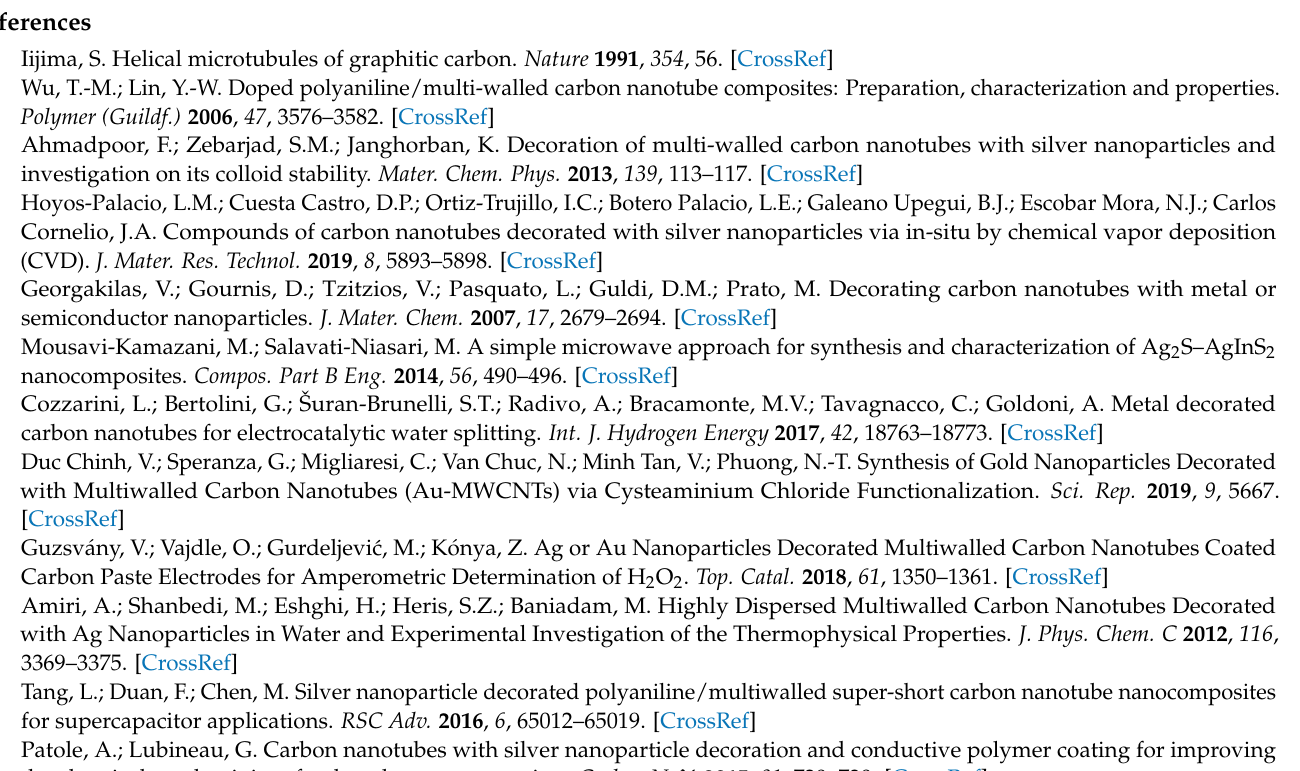
Table S31: two-way ANOVA between the groups of MWCNTs and AgMWCNTs samples dispersed in water with different temperatures (20–60 ◦ C) and concentrations (0–1.0 mg cm − 3